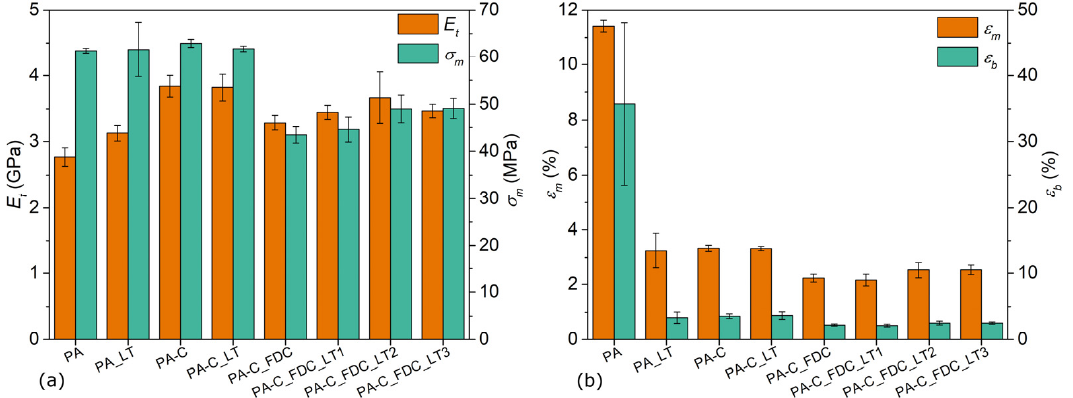
Figure 7. Tensile properties of samples: ( a ) modulus and strength; ( b ) strain at strength and strain at break.